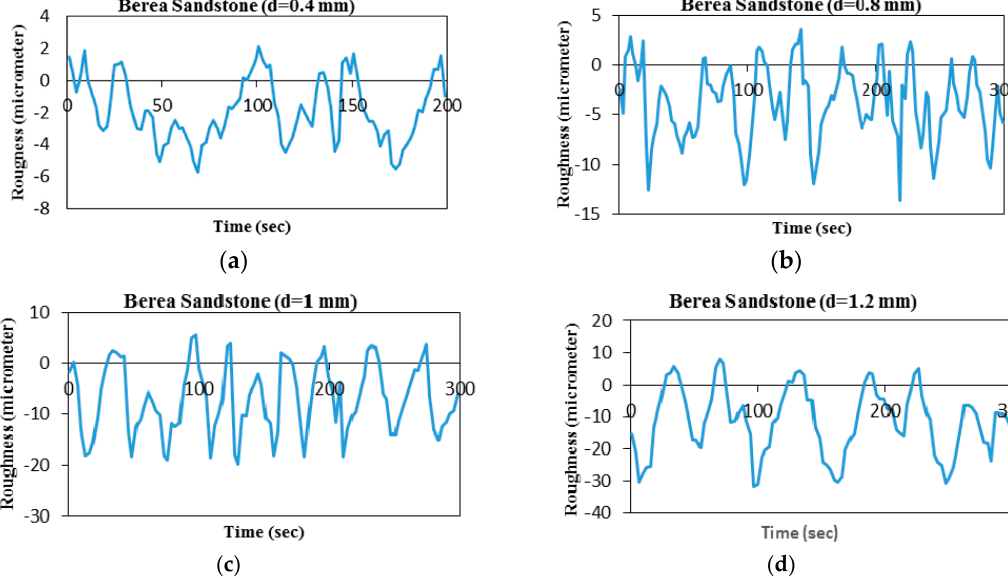
Figure 13. Reproduced groove surfaces with increasing DOC: ( a ) d = 0.4 mm; ( b ) d = 0.8 mm; ( c ) d = 1 mm; ( d ) d = 1.2 mm.